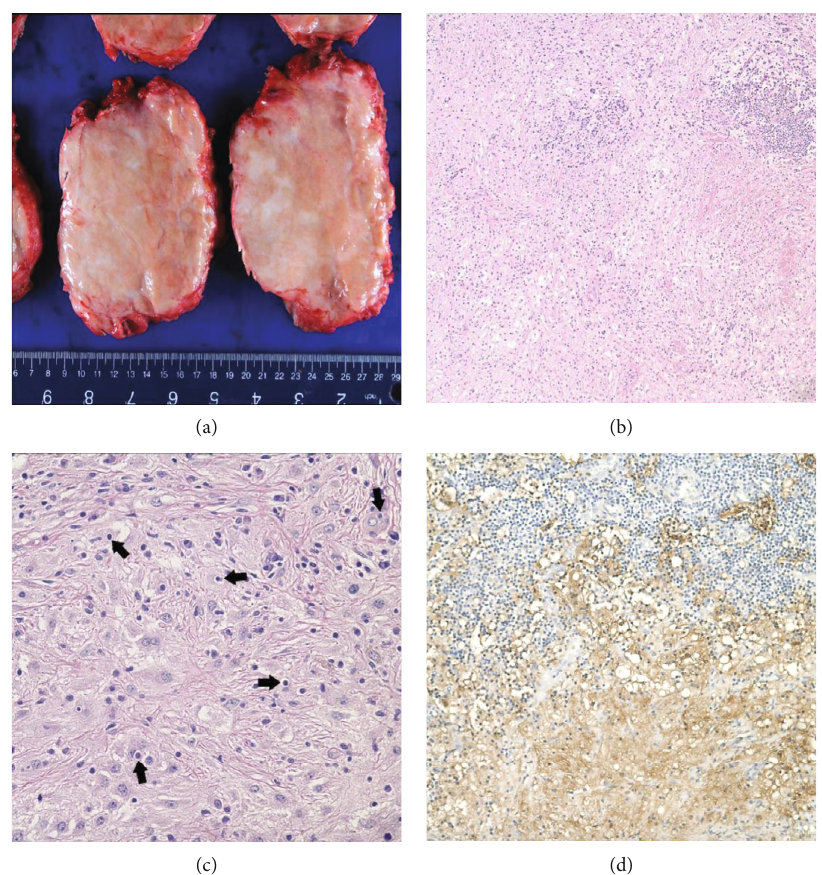
Figure 2: Pathologic analysis of the specimen. (a) Grossly, the lesion was well-circumscribed, unencapsulated, and tan-white in appearance. (b) Microscopically, the lesion was characterized by the presence of “ light ” (histiocyte-rich) and “ dark ” (lymphocyte-rich) areas. (Hematoxylin & eosin [H&E], 100 × ). (c) At higher magni fi cation, emperipolesis (arrows) is appreciated, a classic fi nding in RDD. (H&E, 400 × ). (d) An S100 immunohistochemical stain highlights the histiocytes in both the light (bottom) and dark (top) areas, further supporting the diagnosis of RDD (S100 immunostain, 200 ×